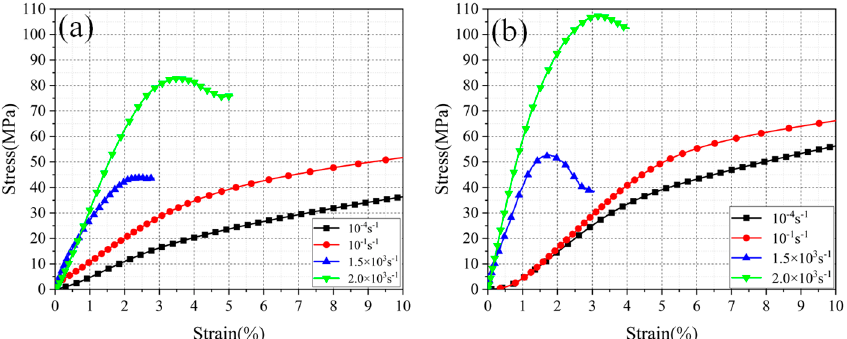
Figure 5. Compressive stress–strain curves of the ( a ) PA12 and ( b ) CF/PA12 under different strain rates.